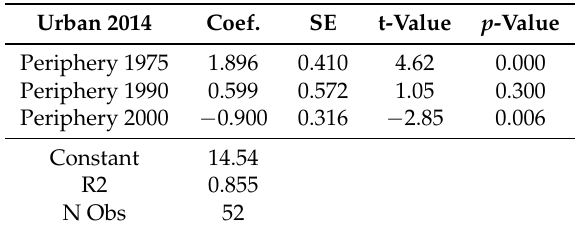
Table 3. Historical peripheries and contemporary urban areas.